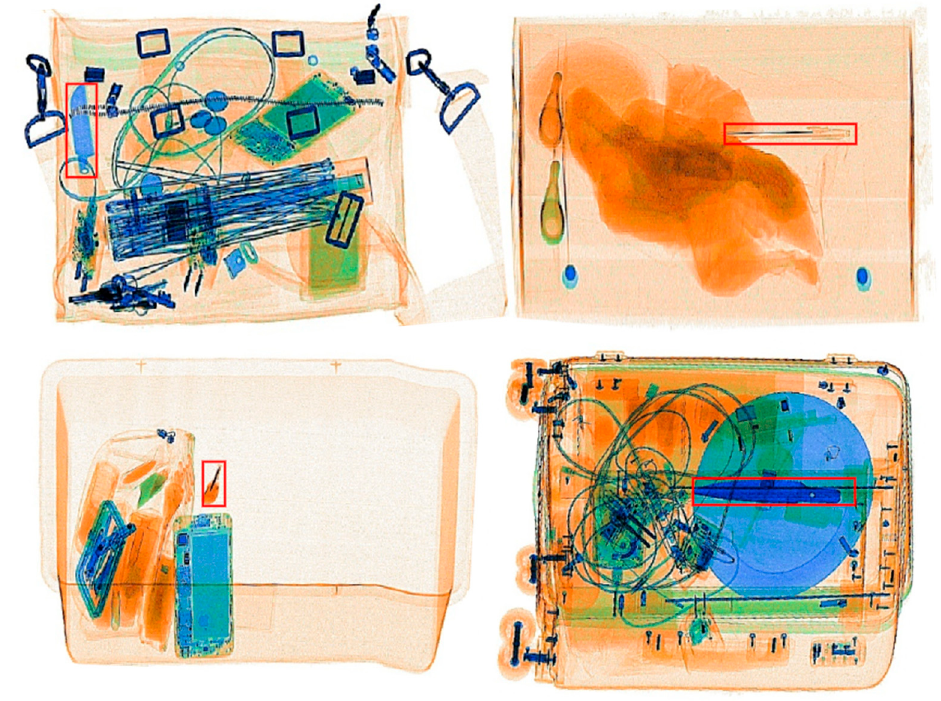
Figure 1. Problem description in X-ray contraband dataset. The first three images show the scale difference problem caused by different views of the same type of contraband and its uneven aspect ratio, and the last image shows the complex occlusion and clutter problem.